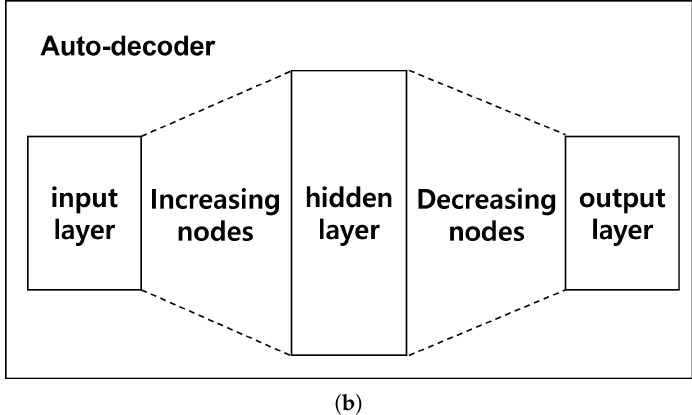
Figure 1. Structure of ( a ) auto-encoder and ( b ) auto-decoder.